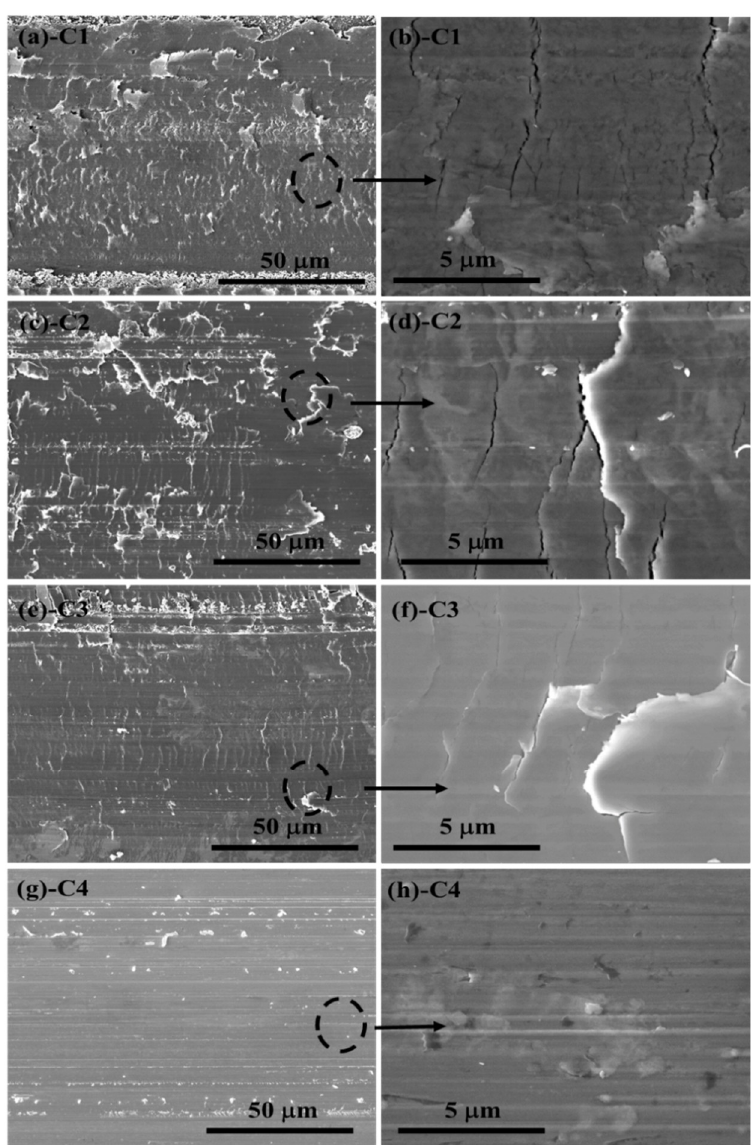
Figure 4. The acoustic signals and critical load of CrN films on 316L substrate.